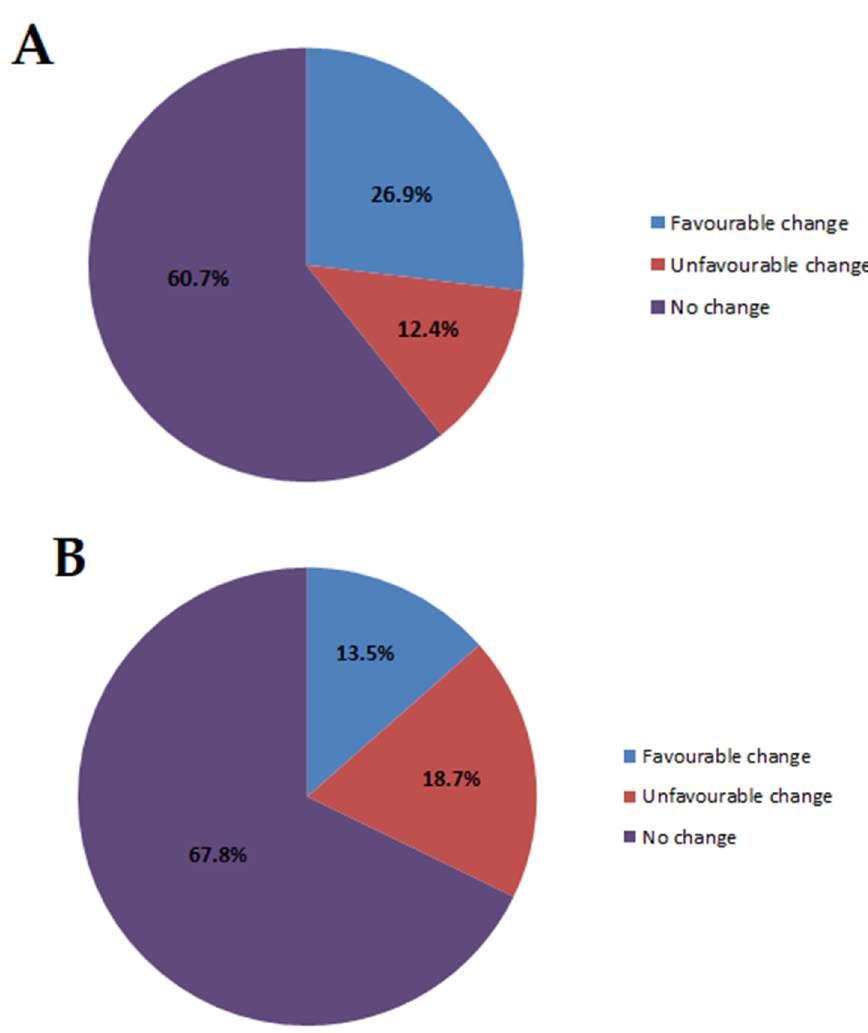
Figure 2. Social or professional changes and / or changes in family relationships in the prospective cohort ( A ) and retrospective cohort ( B